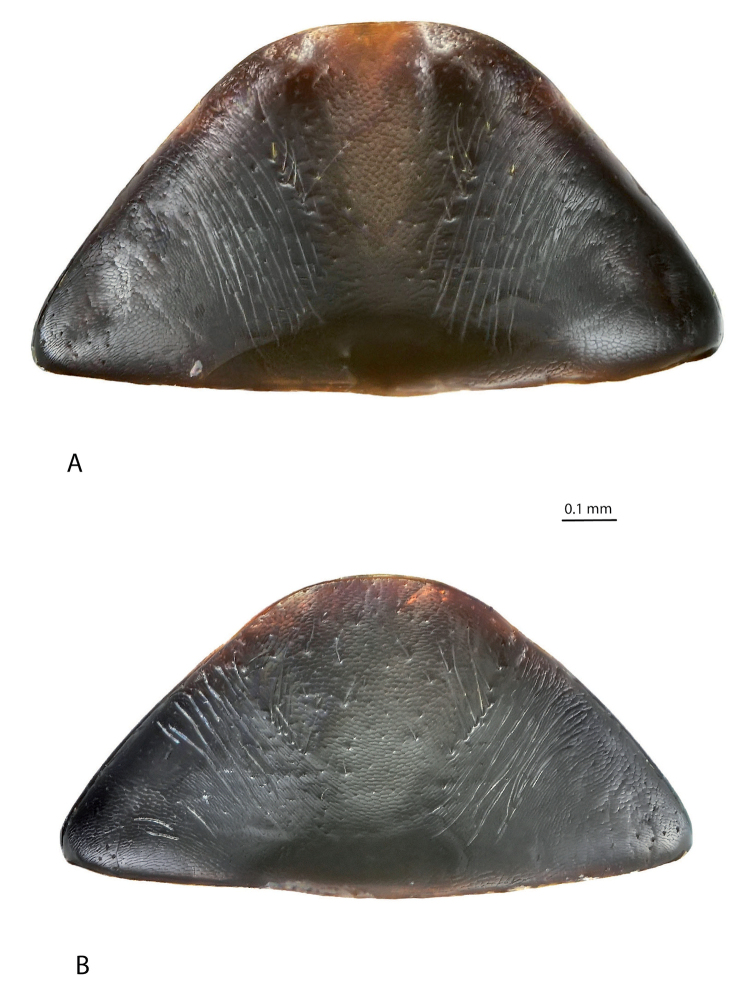
Abdominal ventrite 6 AExocelina
athesphatos sp. nov., paratype BE.
tsinga sp. nov., holotype.